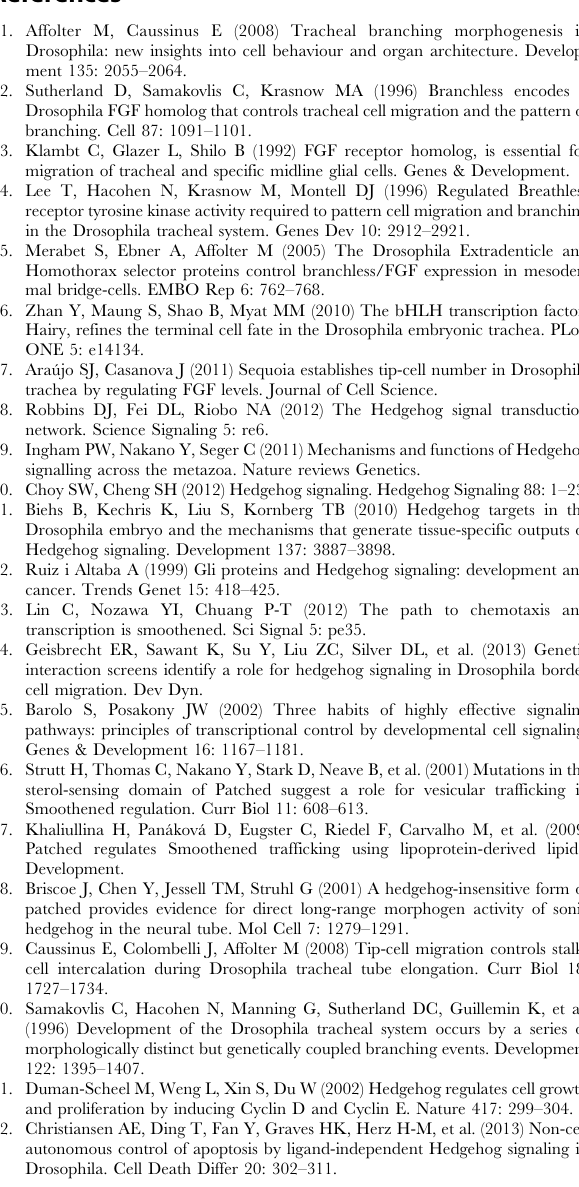
Tables S1 Supporting tables. Table S1, qRT-PCR Results. Table S2, qRT-PCR